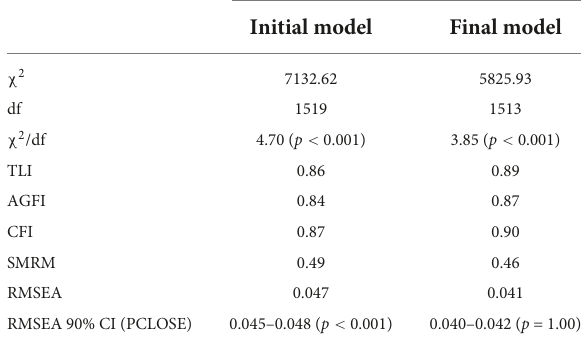
TABLE 2 Model fit